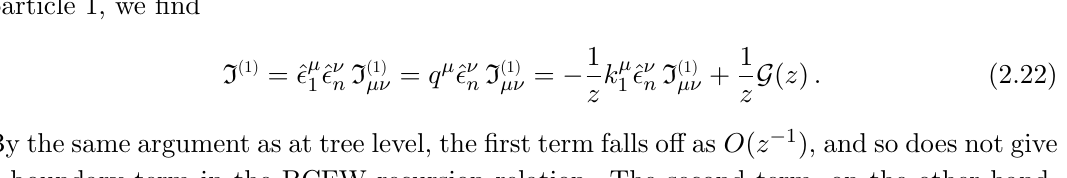
, or q = (cid:15) + . The cases T1 and T2 are distinguished n 1 (cid:1) (cid:15) T = 0 (T2). Figure taken from n 1